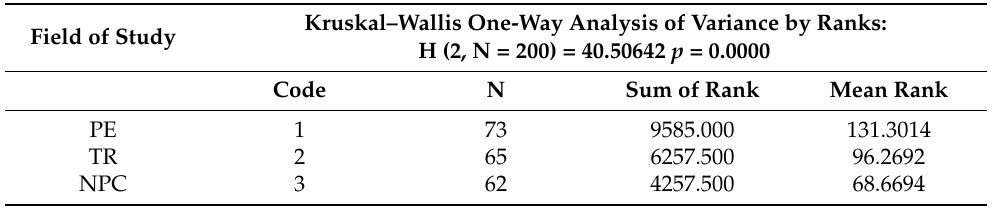
Table 8. Comparison of time spent on high physical activity during the lockdown period. Field of